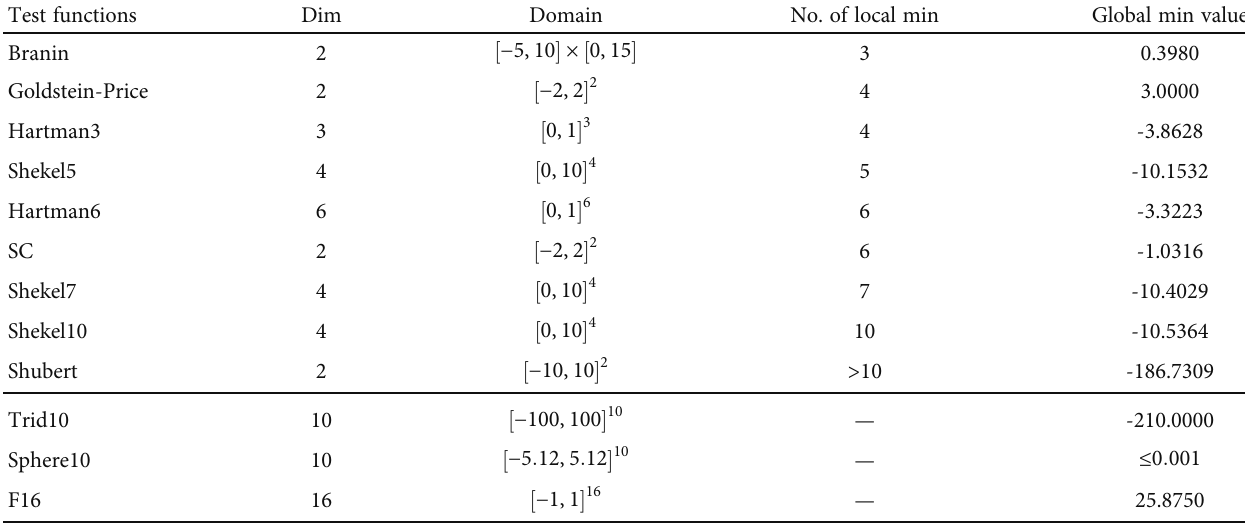
Table 1: Bound-constrained benchmark problems for global